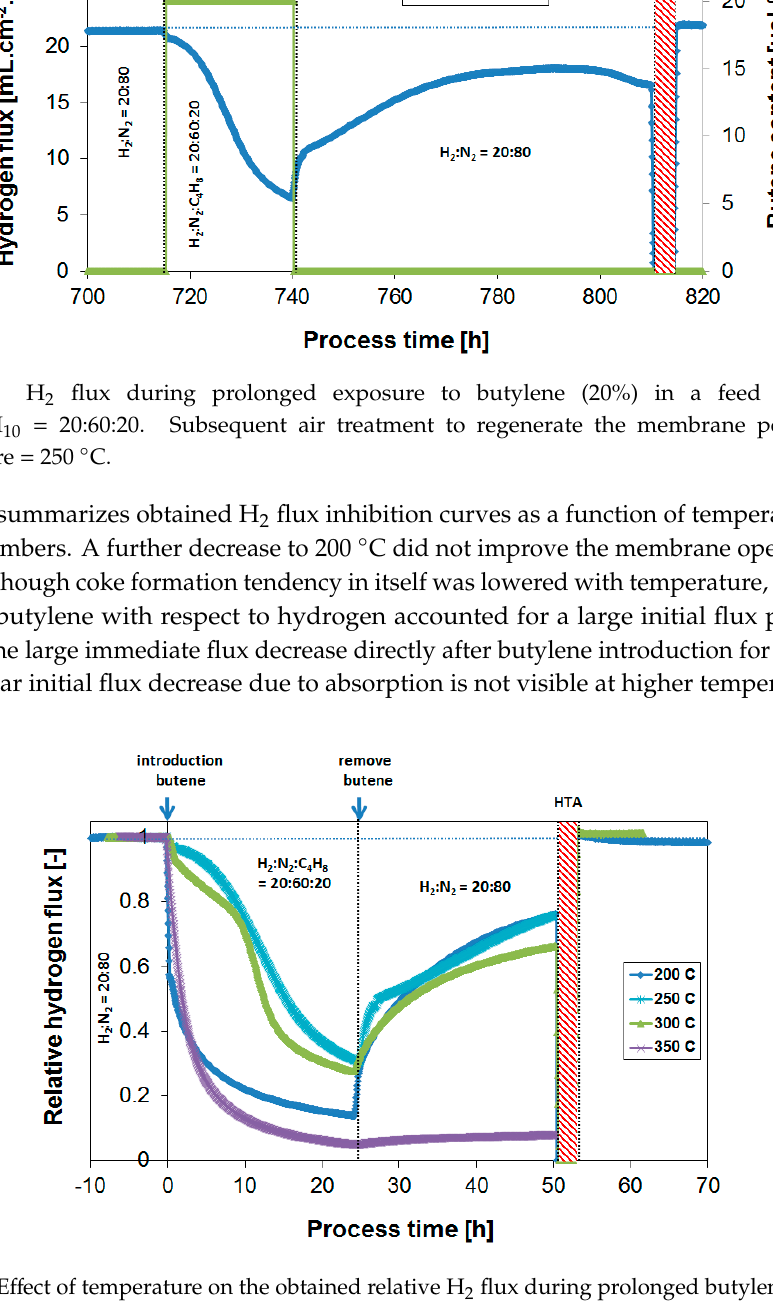
Figure 10. E ff ect of temperature on the obtained relative H 2 flux during prolonged butylene exposure. H 2 :N 2 :C 4 H 10 =